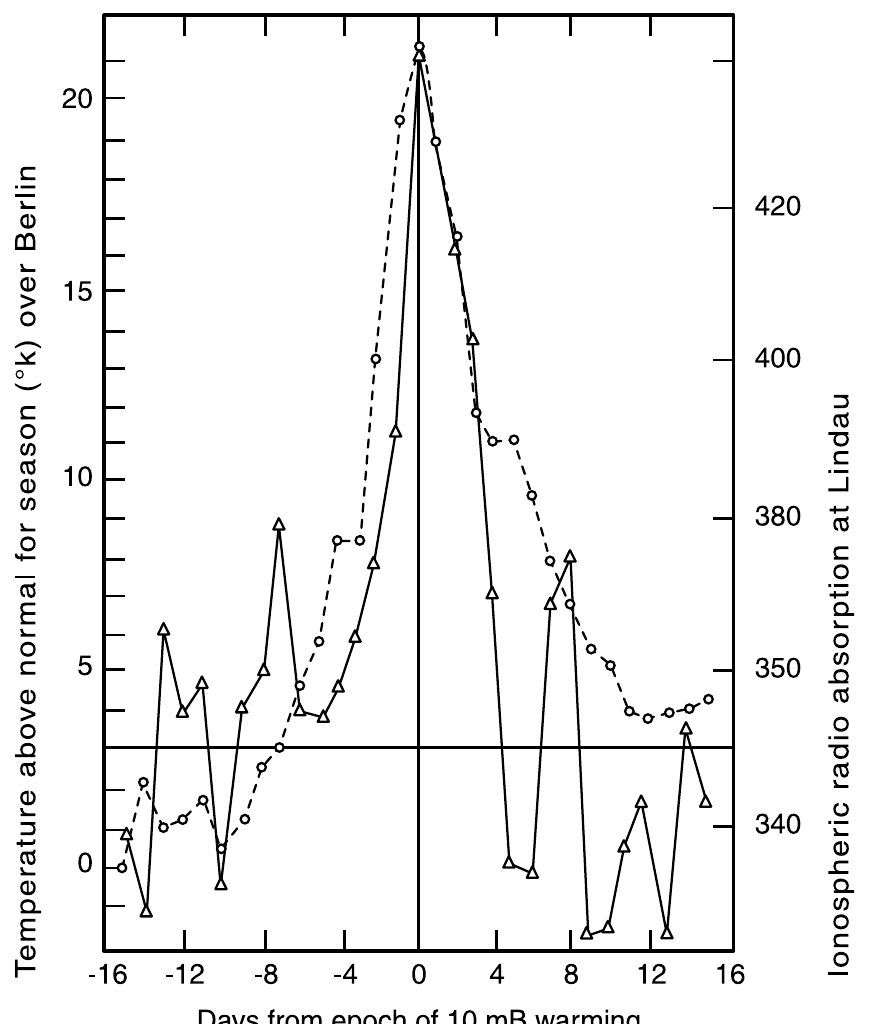
Fig. 3. Superimposed epoch analysis comparing 10 mbar temperature over Berlin, and radiowave absorption over Lindau (Germany) (Shapley and Beynon,